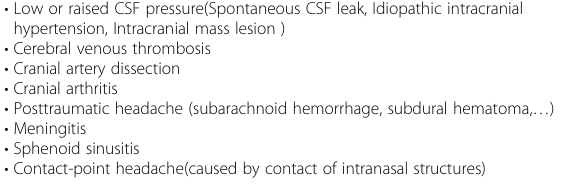
Table 5 (abstract P116). Secondary mimics of